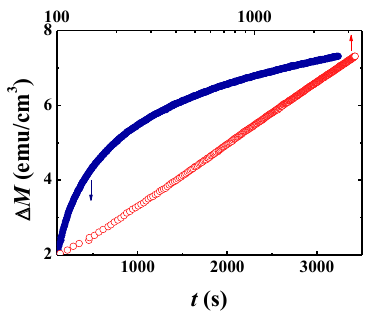
Fig. 3. Time dependence of magnetic moment Δ M ( t ) at T = 300 K in external magnetic field H = 9 kOe in normal and semi- logarithmic coordinates.